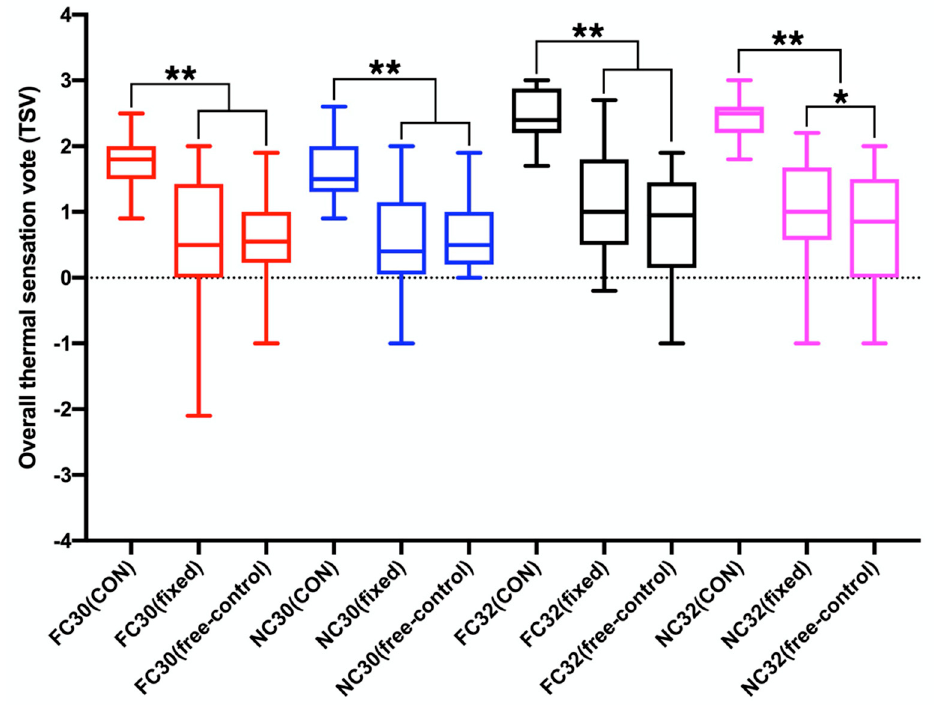
Figure 3. Overall thermal sensation votes (TSVs). *, p < 0.05; **, p < 0.001.